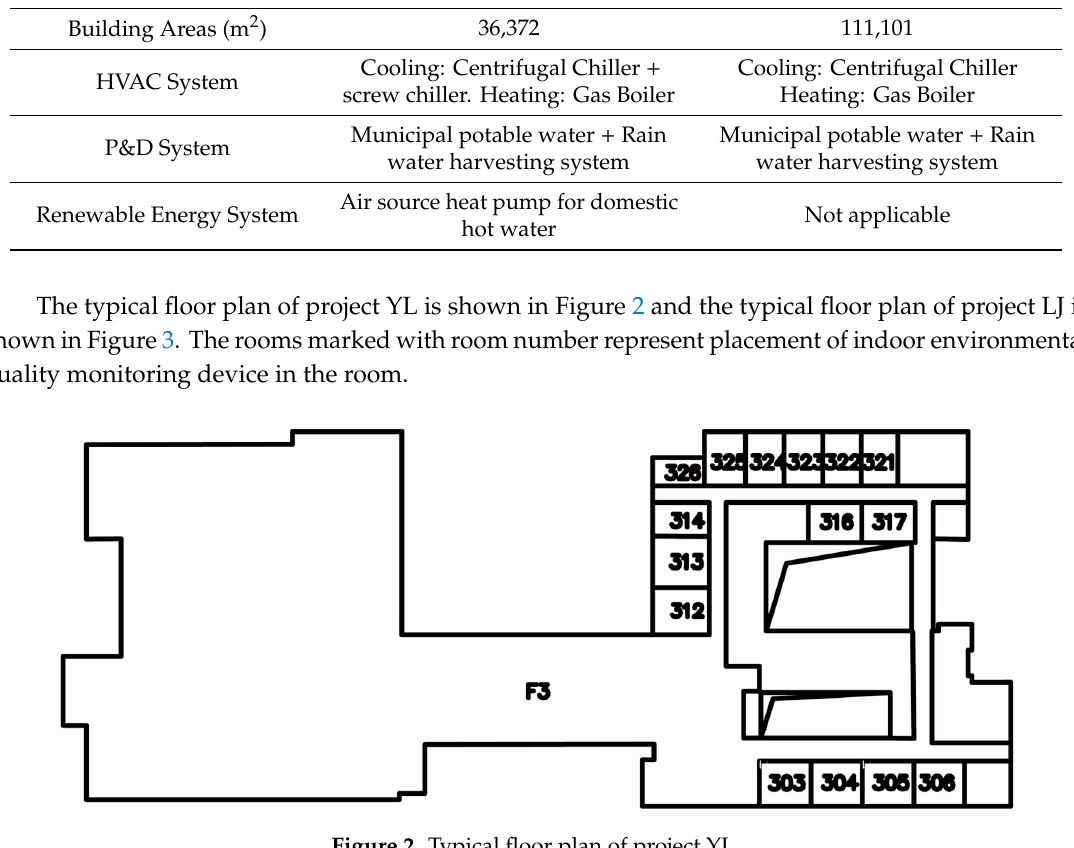
Table 4. The specifications of the two projects for case study.